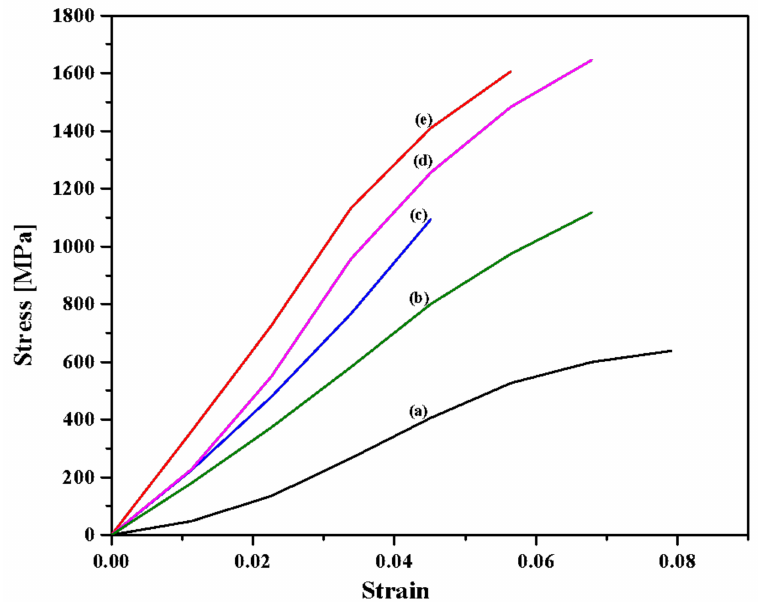
Figure 2. Stress-strain curves for ( a ) untreated PALF, ( b ) 1, ( c ) 3, ( d ) 6, and ( e ) 9% wt/wt NaOH treated PALF. The NaOH treatment of the PALF resulted in an increment in fiber UTS values and a decrement in strain at break values. Table 1. Summary of tensile properties of untreated and NaOH treated PALF samples.